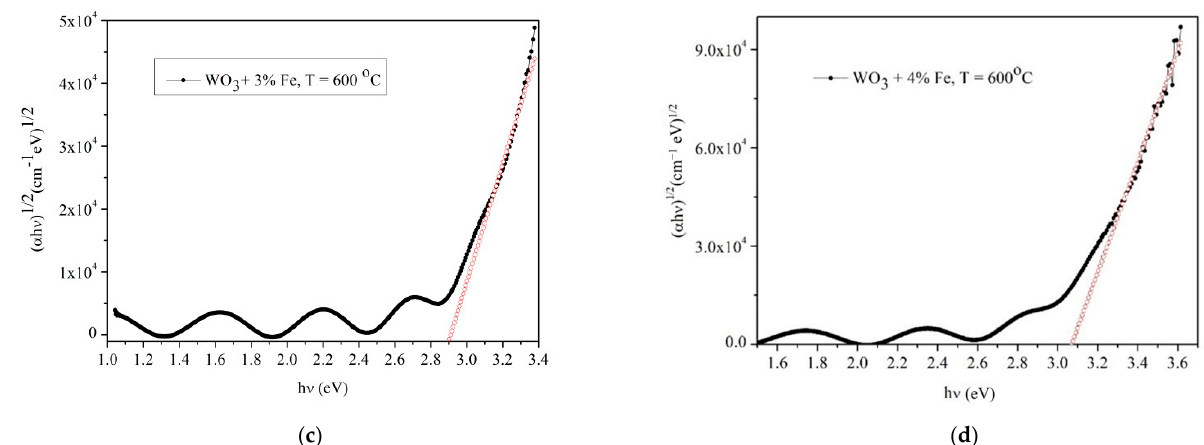
Figure 12. Optical band gap of pure WO 3 layers grown on sapphire substrates:( a ) 2% Fe-doped WO 3 at 600 °C; ( b ) 2% Fe- doped WO 3 at 700 °C; ( c ) 3% Fe-doped WO 3 at 600 °C; ( d ) 4% Fe-doped WO 3 at 600 °C.